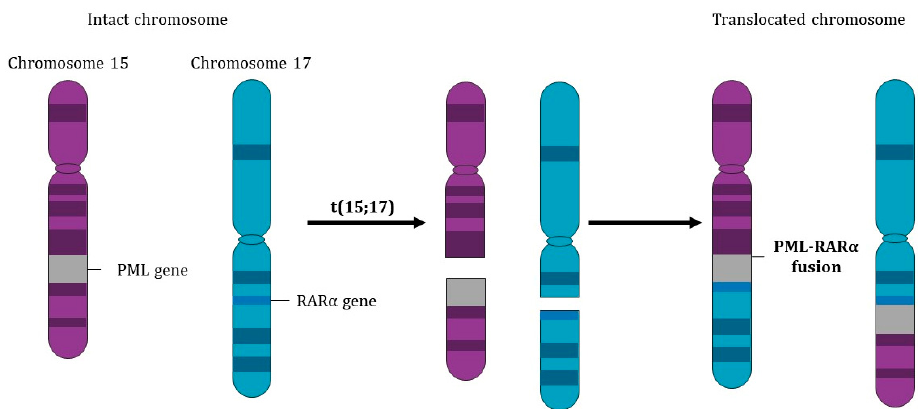
Figure 1. Chromosomal translocation between chromosomes 15 and 17. Acute promyelocytic leukemia is associated with the chromosomal translocation t(15;17)(q22;q21), which results in the fusion of genes PML and RAR α .